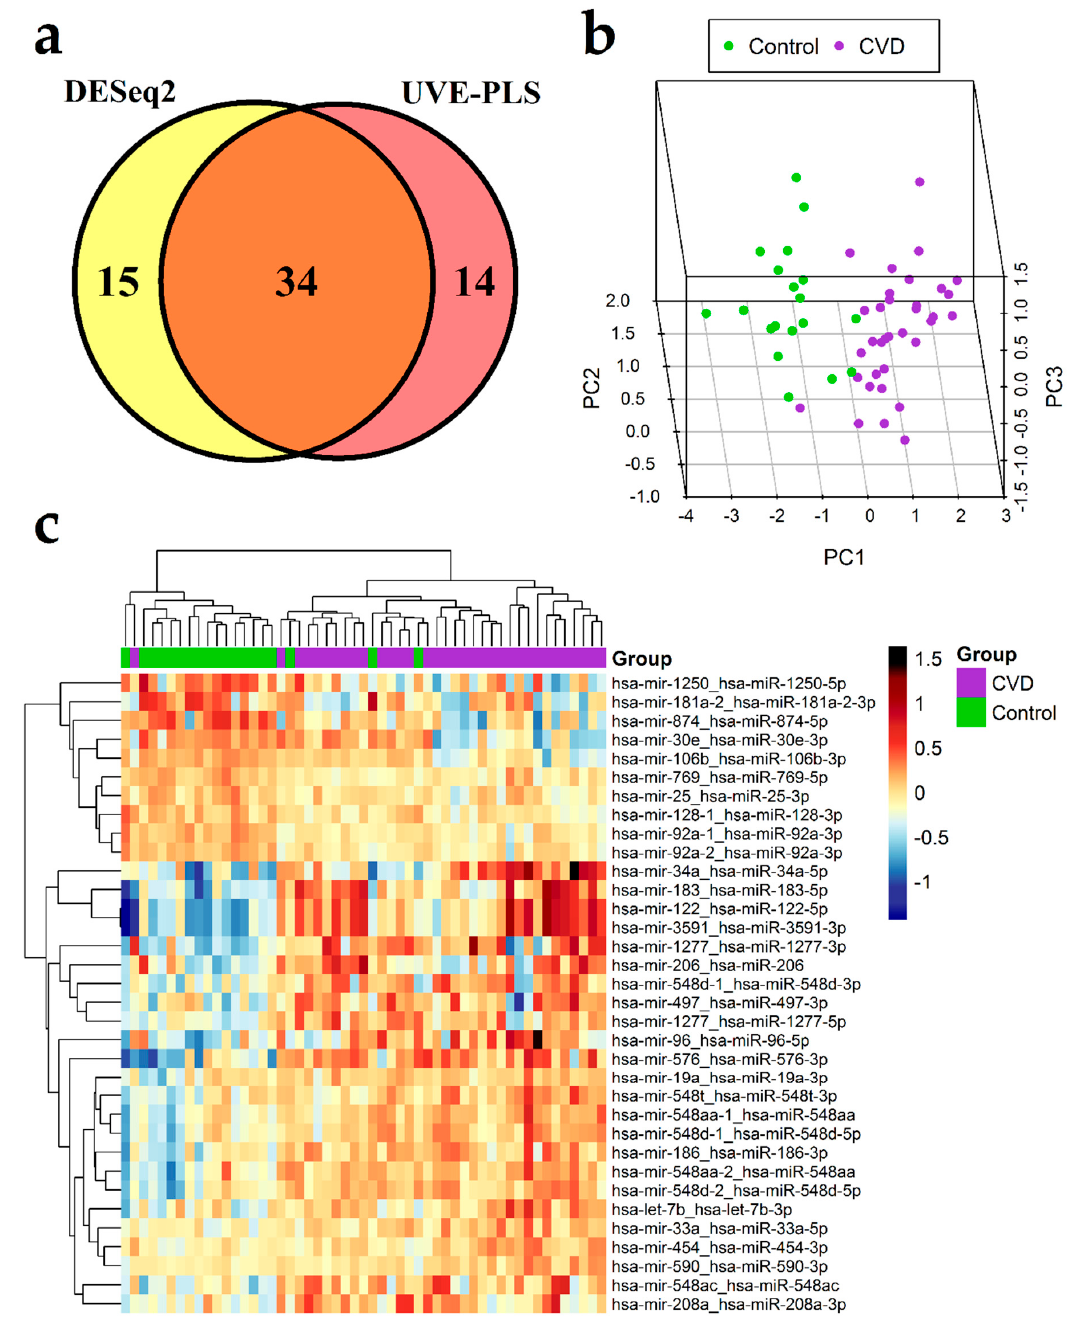
Figure 2. Results of di ff erential expression analysis of miRNA in group of 34 patients with chronic venous disease (CVD) vs. 19 healthy controls (Control). ( a ) Venn diagram presenting comparison of two sets of miRNA transcripts: the set of 49 miRNA transcripts resulted from DESeq2 analysis with p < 0.01 and the set of 48 informative miRNA transcripts resulted from Uninformative Variable Elimination by Partial Least Squares (UVE-PLS) analysis. Thirty-four miRNA transcripts were common for both sets. 3D Principal Component Analysis (PCA) plot ( b ) and heatmap with Euclidean clustering ( c ) show di ff erential expression of common 34 miRNA transcripts in CVD and control groups.